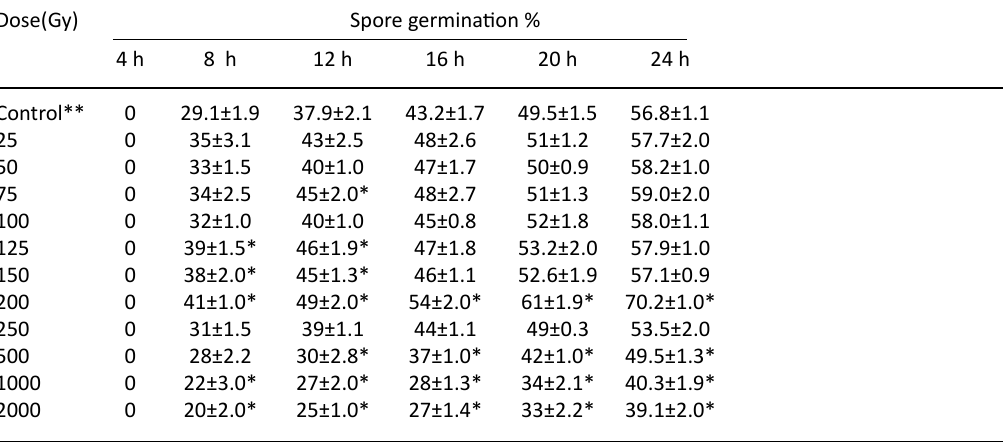
Table 1. Spore germination percentages of Penicillium chrysogenum after irradiation with gamma rays